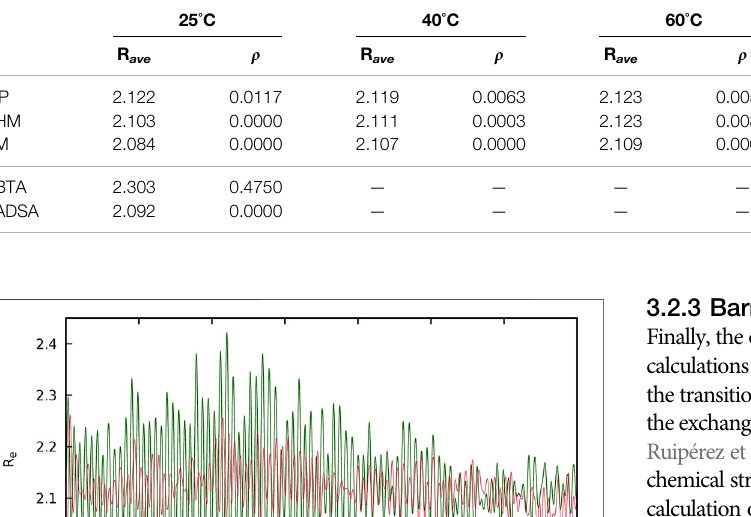
TABLE3| AverageS-Sbonddistances(R ave ),inÅ,obtainedinQMDsimulations,andprobabilitytogeneratesulfenylradicals( ρ )asafunctionoftemperature.Thecalculated temperatures are those in which experiments were performed, 25, 40, 60, and 80 ° C for IP, HM and M, and 25 ° C and 120 ° C for BTA and ADSA.